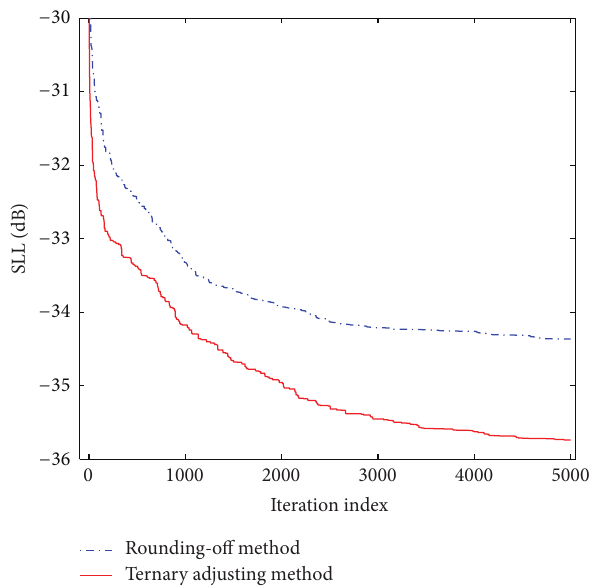
Figure 3: Comparison of global best values averaged over 20 independent trials.